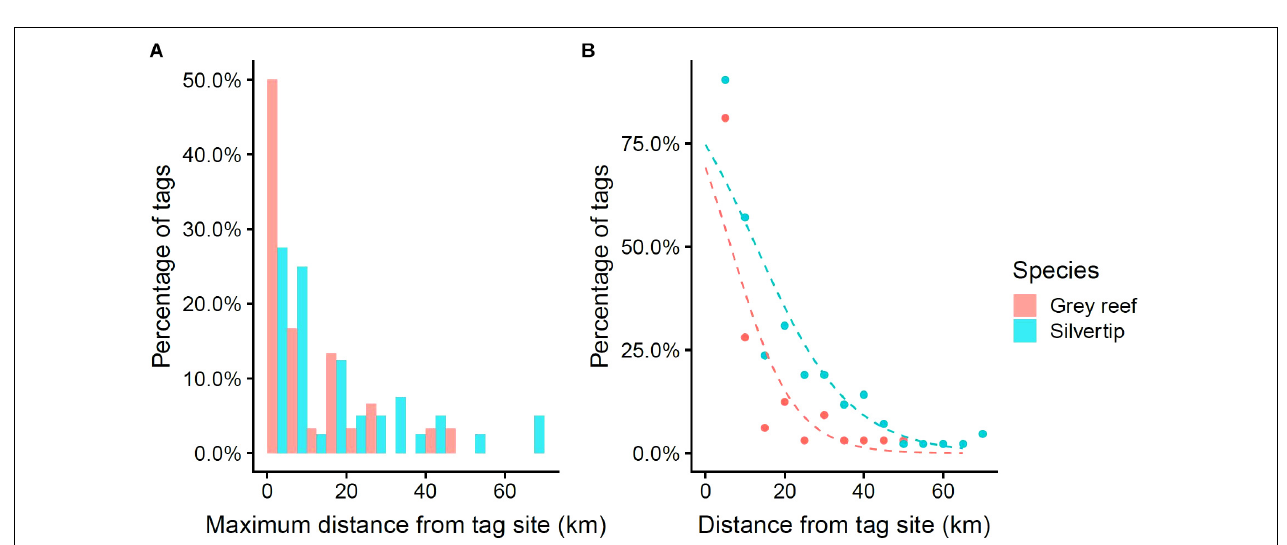
FIGURE 5 | (A) Distribution of tags of each species by maximum distance detected from tagging location. (B) Probability of detecting tags by distance of receiver from initial tagging location, by species. Points are observed values. Dashed lined are predictions from a binomial GLM of detection probability, including an interaction between receiver distance and